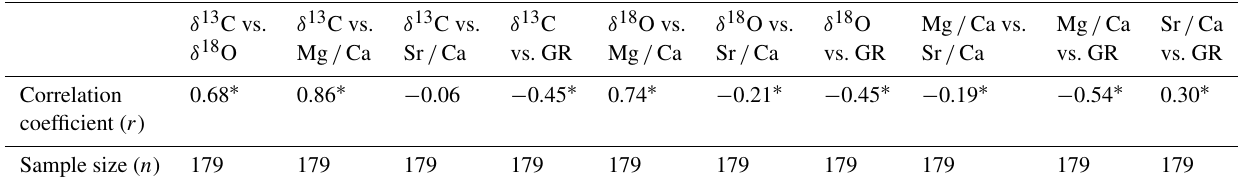
Table 1. Correlation coefficients ( r ) for the different proxies ( δ 18 O, δ 13 C, Mg / Ca, Sr / Ca and growth rate) from stalagmite SIR-14 for the period between 11.7–6.4ka. Correlation coefficients that are statistically significant ( p value < 0.05) are marked with an asterisk. See Fig. S3 for cross plots of the correlation between the various proxies. δ 13 C